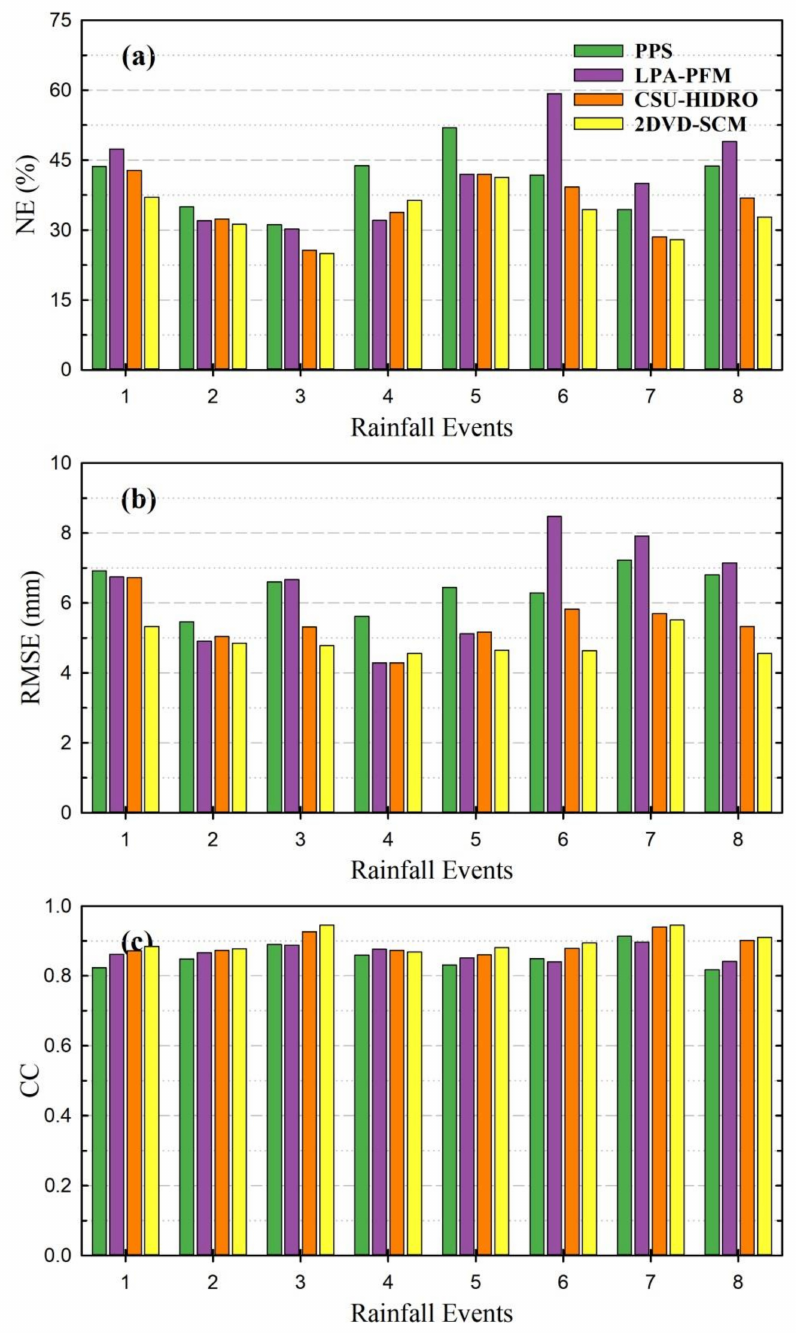
Figure 8. Bar graphs showing ( a ) NE (%), ( b ) RMSE (mm/h), and ( c ) CC (non-dimensional) obtained from QPE algorithms of PPS, LPA-PFM, CSU-HIDRO, and 2DVD-SCM for eight monsoon rainfall events. Scatterplots of these four QPE algorithms estimated and gauge-observed the hourly rainfall are given in Figure 9. The data scatters of PPS and LPA-PFM algorithms are sensitively larger than CSU-HIDRO and 2DVD-SCM algorithms. The NE and RMSE values are 43.37% and 6.938 mm for LPA-PFM, which are the highest among these four QPE algorithms. The NE and RMSE (CC) values of 2DVD-SCM are obviously smaller (larger) than the other three typical QPE